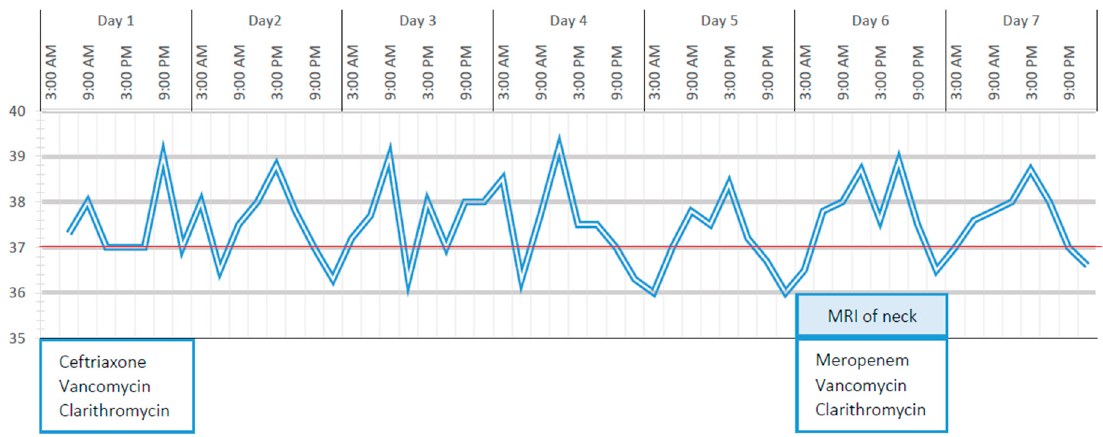
Figure 1. Body temperature and antibiotic therapy during the first 7 days of hospitalisation.